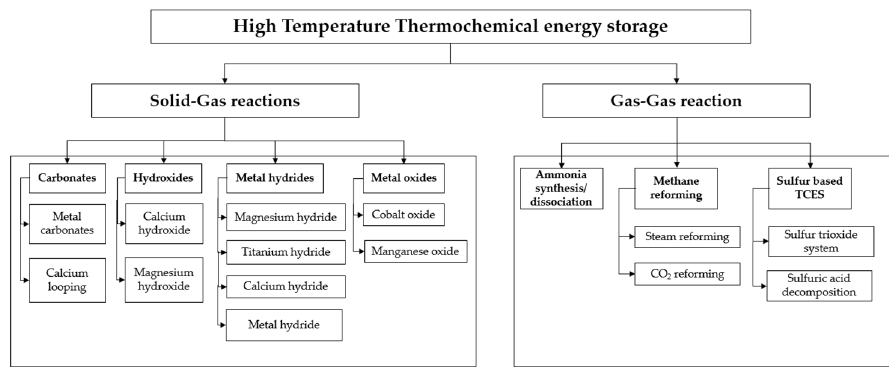
Figure 8. Thermochemical accumulation reactions.